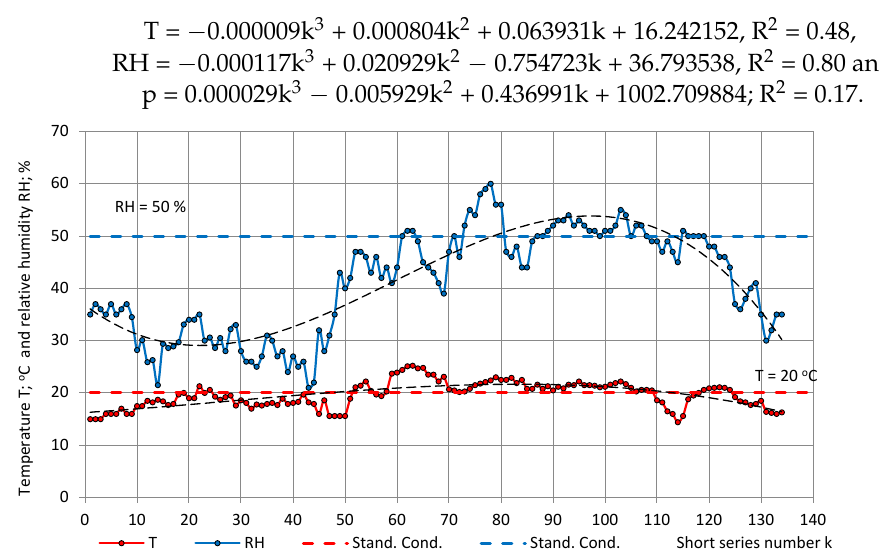
Figure 4. Atmospheric temperature T (red) and relative humidity RH (blue) in the test room in the short